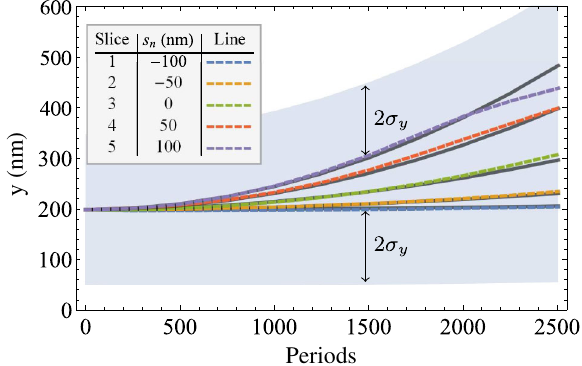
FIG. 7. Comparison of slice center of mass for a tracked bunch divided into five slices (dashed lines) with the analytical description (black solid lines). The gray area shows the 2 σ distance to the minimum and maximum curve. The aperture of the dual pillar structure with 2 μ m period length is at y ¼ 600